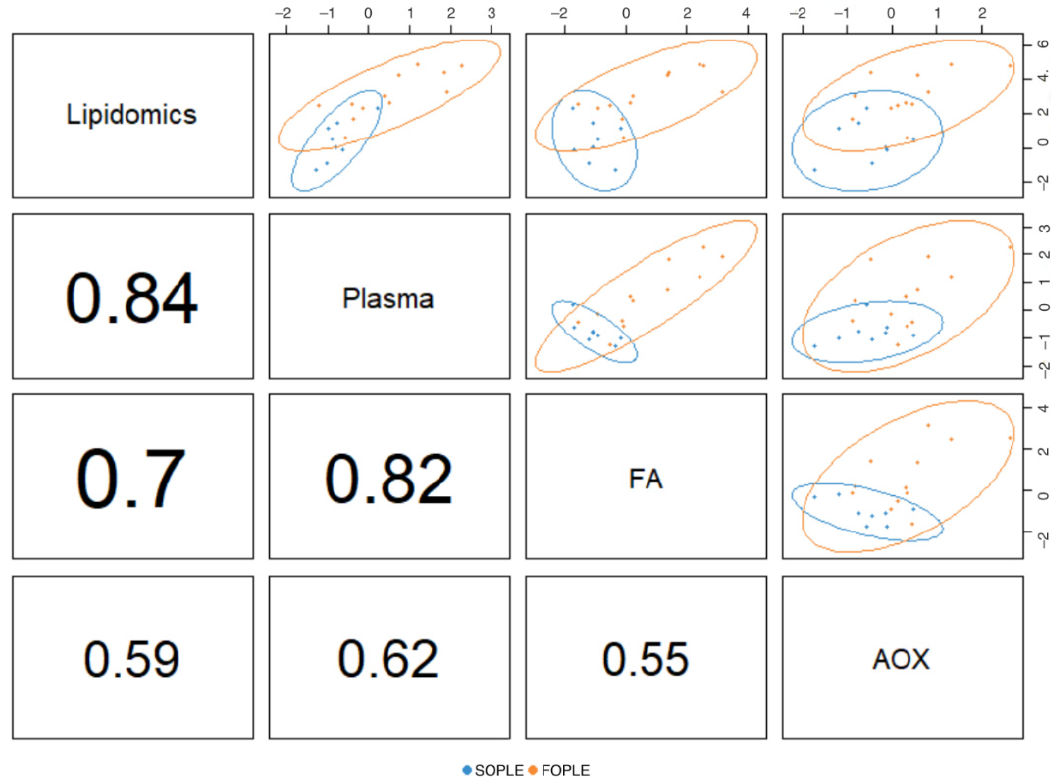
Figure 3. Correlation matrix corresponding to the unique component of the DIABLO model com- paring the four data blocks. AOX: antioxidant enzyme activities , FA: fatty acids; plasma, measure- ments in plasma (including general biochemistry and FA). FOPLE: Fish-oil based formula; SOPLE: SO-based formula. The values presented correspond to the R 2 ; a value closer to 1 reflects a better association between pairs.